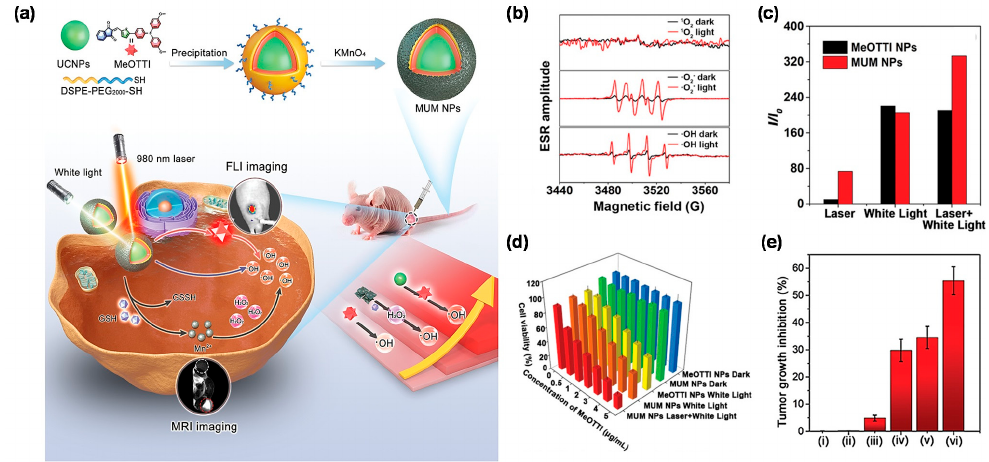
Figure 6. ( a ) Chemical structure of MeOTTI and schematic illustration of triple-jump photodynamic theranostic protocol. ( b ) ROS generation type of MeOTTI determined by ESR test. ( c ) ROS production efficiency of MeOTTI NPs and MUM NPs at the same MeOTTI concentration under the irradiation of different light sources. ( d ) Cell viability of 4T1 cells treated with different conditions. ( e ) Tumor inhibition ratios of mice after different treatments, namely: (i) PBS, (ii) MUM NPs, (iii) 980 nm laser and white light, (iv) MeOTTI NPs and white light, (v) MUM NPs and white light, (vi) MUM NPs, 980 nm laser and white light ( n = 5, * p < 0.001). Reprinted with permission from [63], copyright 2021, Wiley-VCH.